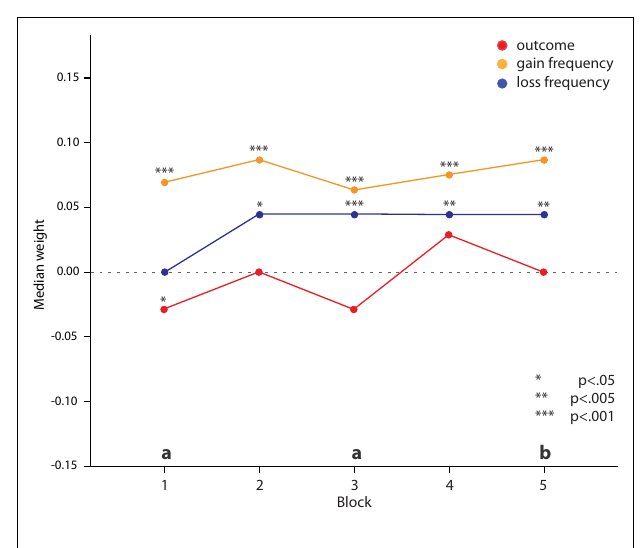
FIGURE 3 | Estimated median weights for the features long-term outcome (red), gain frequency (orange), and loss frequency (blue) over the five consecutive blocks of 20 choices based on all participants. Asterisks indicate the level of significance ofWilcoxon signed rank test against zero, a ( p < 0.001), and b ( p < 0.005) indicate the level of significance of Friedman tests comparing the weights within each block.